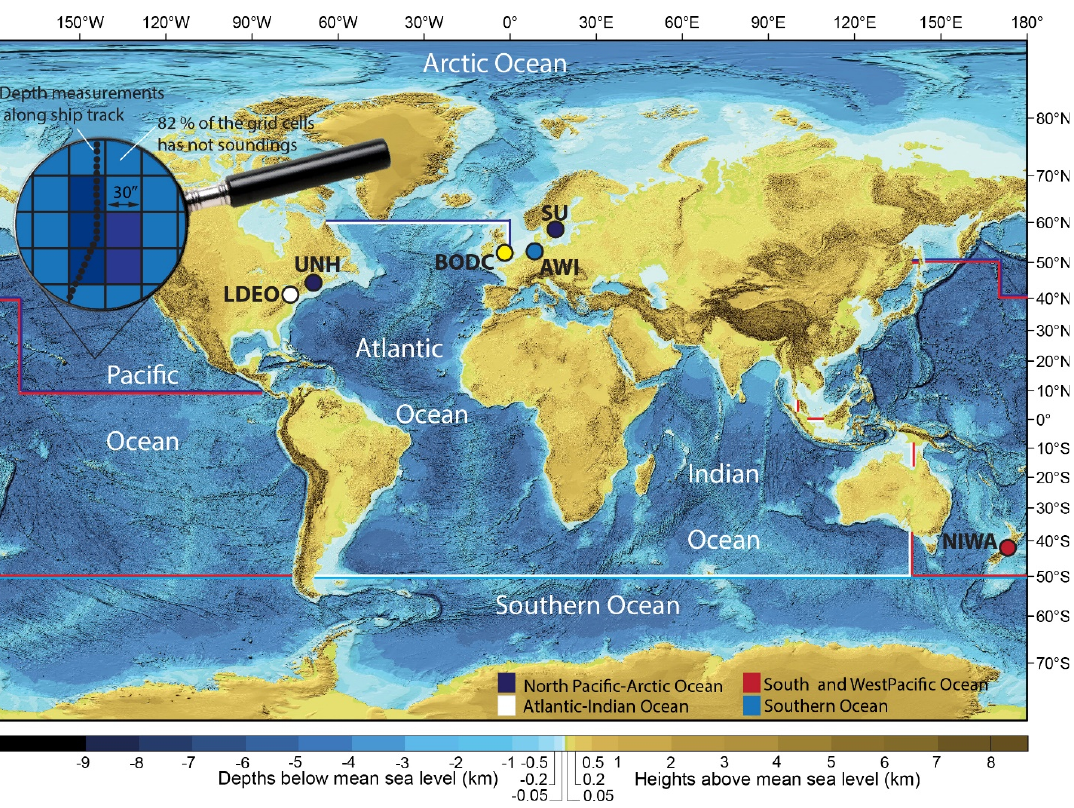
Figure 1. A shaded relief of the GEBCO_2014 grid modified from [1]. The oceans have been divided into four geographic regions each managed by a Seabed 2030 Regional Data Assembly and